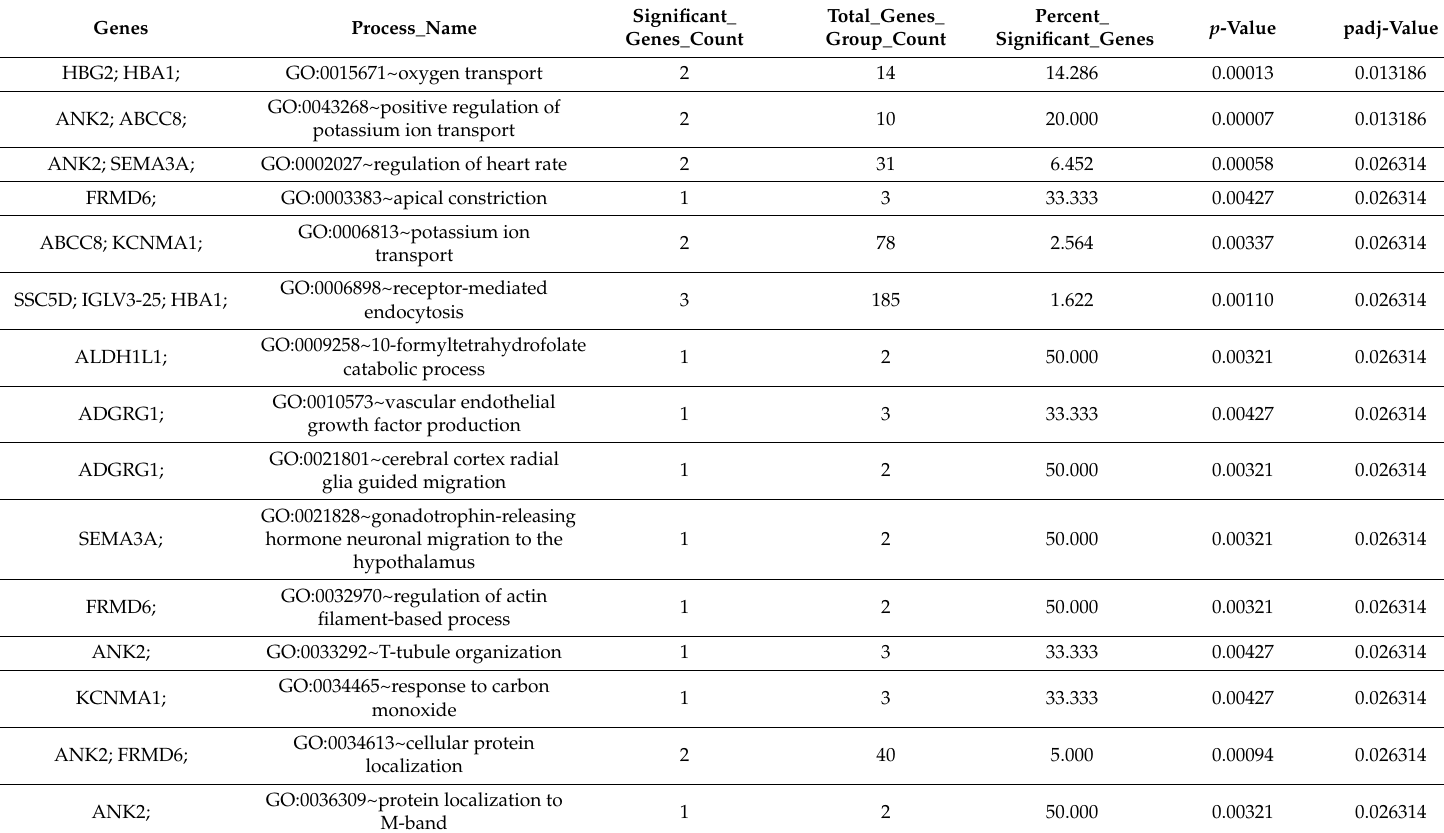
Table 4. The 20 most significant di ff erent pathways between HD gene carriers and healthy